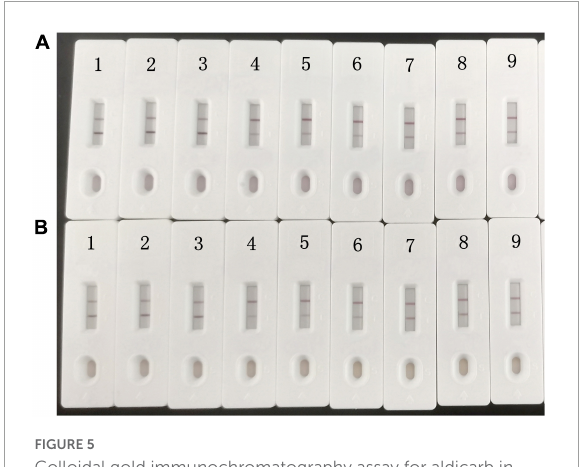
FIGURE5 Colloidal gold immunochromatography assay for aldicarb in samples. Aldicarb concentration 1, 2, 3 = 0 µ g/kg; 4, 5, 6 = 60 µ g/kg; 7, 8, 9 = 30 µ g/kg. (A) Cabbage. (B)